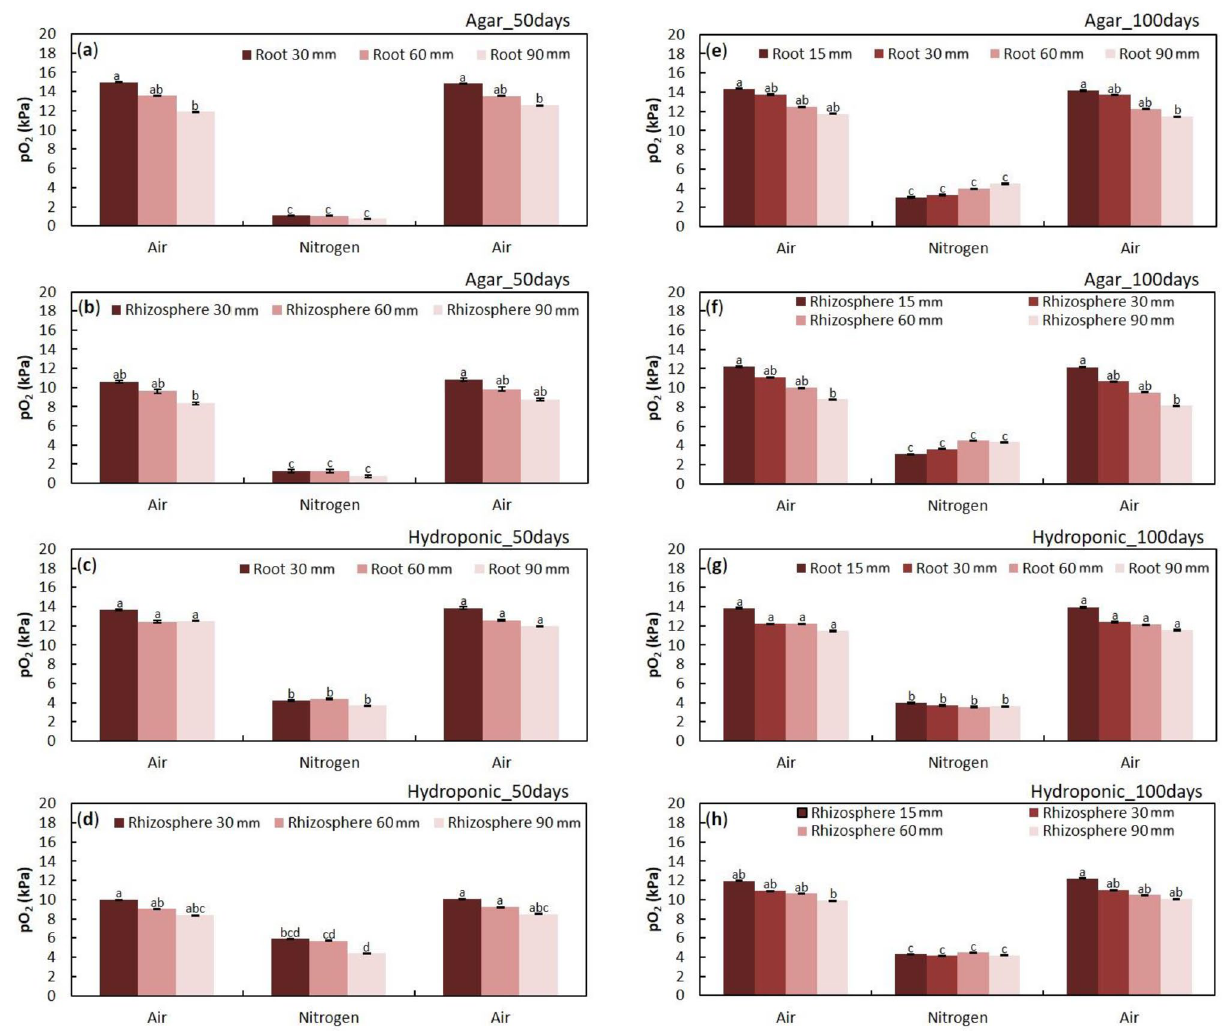
Figure 1. Changes in oxygen partial pressures in the root and rhizosphere after 50 and 100 days of treatment on hydroponic and agar media. The pO 2 was measured at four different positions (15, 30, 60, and 90 mm from the root-shoot junction). N 2 was injected for 30 min, then air was injected for 60 min. Values presented are the average of the last minute before the treatment was changed. The pO 2 in ( a ) the roots and ( b ) rhizosphere of transplants grown in agar medium for 50 days. ( c ) pO 2 in roots grown in hydroponic medium for 50 days. The pO 2 in ( d ) the root surface of transplants grown in hydroponic medium for 50 days. The pO 2 in ( e ) the roots and ( f ) rhizosphere of transplants grown in agar medium for 100 days. ( g ) pO 2 in roots grown in hydroponic medium for 100 days. The pO 2 in at ( h ) the root surface of transplants grown in hydroponic medium for 100 days. Data are shown as Means ± standard deviations ( n = 6–7 roots from six individual plants, average of the last minute before changing the treatments). The same letter indicates no significant difference between measurements ( p < 0.05, one-way ANOVA and then Tukey’s test for multiple Root primary aerenchyma with collapsed cortex. To clarify the continuity between the primary aerenchyma and secondary aerenchyma that developed near the collapsed cortex in adventitious roots, the oxygen electrodes were placed in the primary aerenchyma and the rhizosphere, approximately 10 cm from the root-shoot junc- tion where the cortex collapse had occurred (Fig. 3c). The N 2 or air injection induced a decrease or increase of pO 2 in both the primary aerenchyma and rhizosphere. When N 2 or oxygen was injected into the stem base, the value of pO 2 in the rhizosphere changed later than in the primary aerenchyma (Fig. 2e). When air was injected into the stem base, the pO 2 in primary aerenchyma was higher than that of the rhizosphere. The pO 2 in primary aerenchyma was lower than that of the rhizosphere when N 2 was injected into the stem base (Fig. 2e,f). The pri- mary and secondary aerenchyma were continuous, and there were no significant differences between pO 2 in the primary aerenchyma and the rhizosphere, indicating that oxygen is transported from the primary aerenchyma of the collapsed cortex to the rhizosphere.